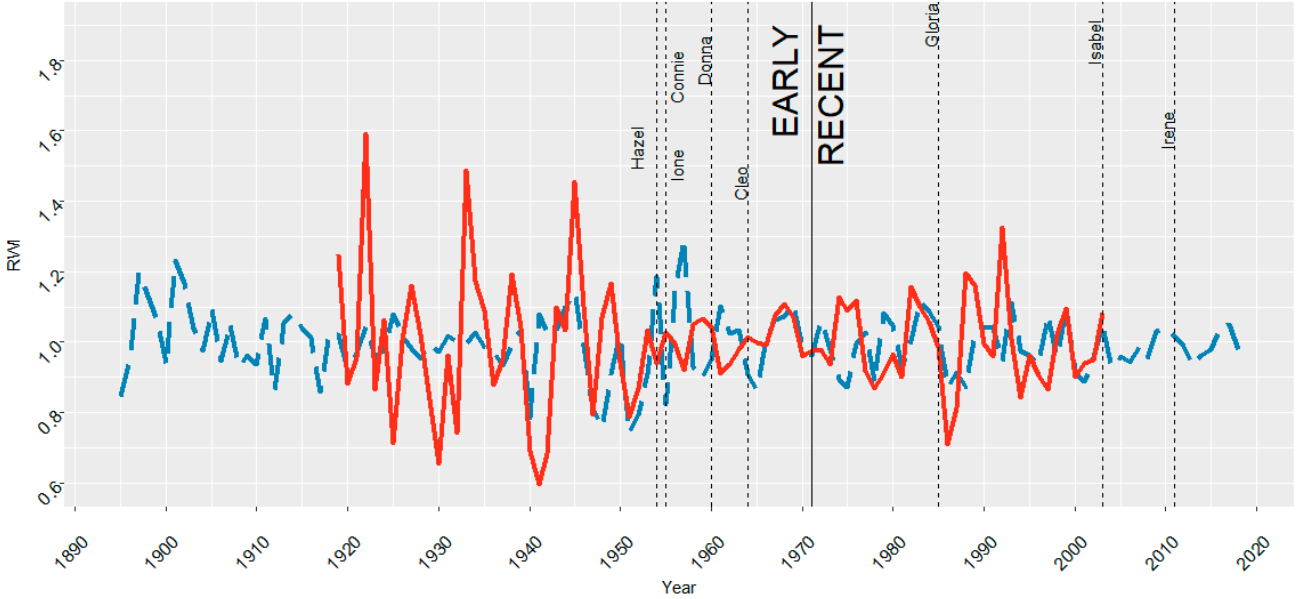
Figure 2. Ring Width Index (RWI) for the full study period, 1895–2018. ARNWR (dashed blue) spans 1895–2018 and GDSNWR (red) spans 1919–2003. Years 1971/1972 denote division of early and recent periods. The five most intense named hurricanes in ARNWR (based on wind speed in the area of interest) and three of regional importance from published studies are labeled. Higher names indicate greater relative intensity.